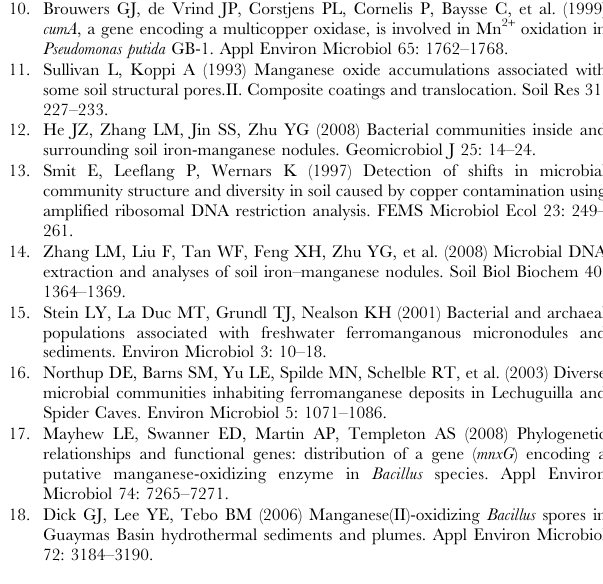
Figure S1 Phylum-level phylogenetic diversity and abundance of the 16S rRNA gene sequences from culturable bacteria with high Mn(II)-oxidizing activities. Sequences were assigned to their respective phyla by using the RDP classifier software.